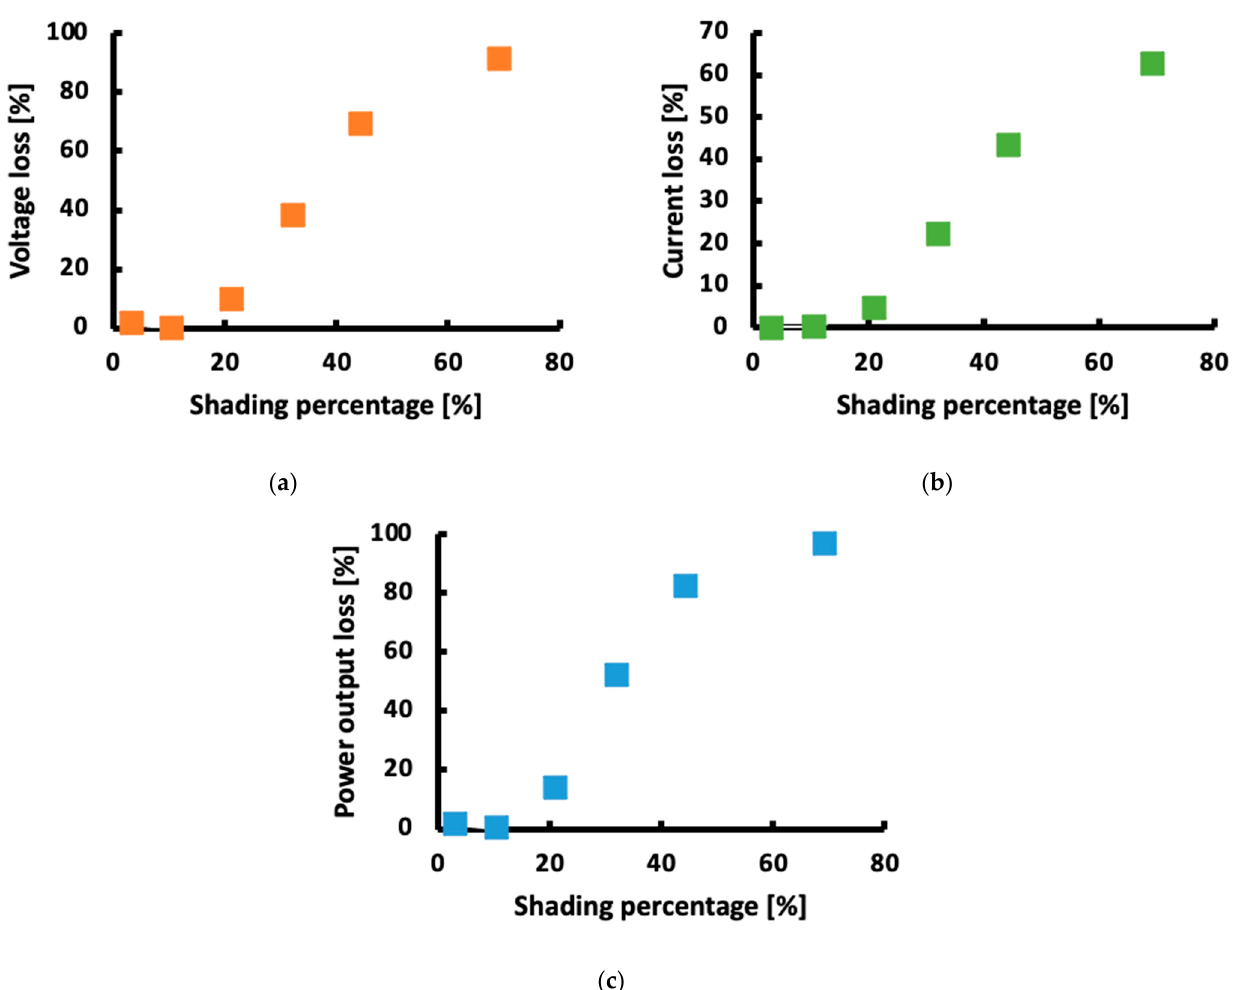
Figure 9. The relation between shading percentage on the first PV cells PV modules in array A: ( a ) voltage loss, ( b ) current loss, and ( c ) power output loss.